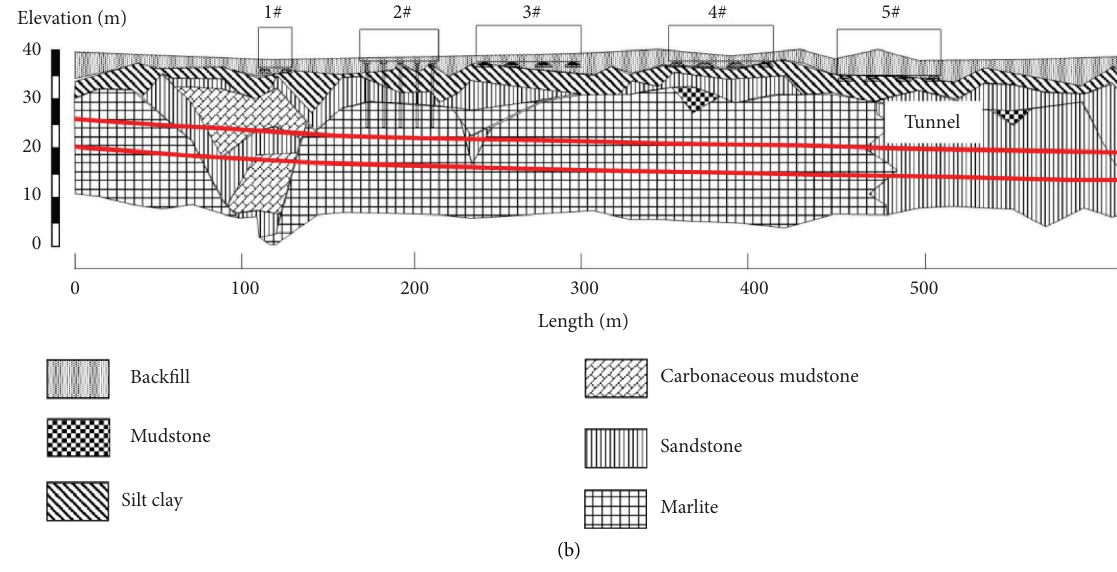
Figure 4: Geological profle of fve buildings: (a) right line; (b) left line.